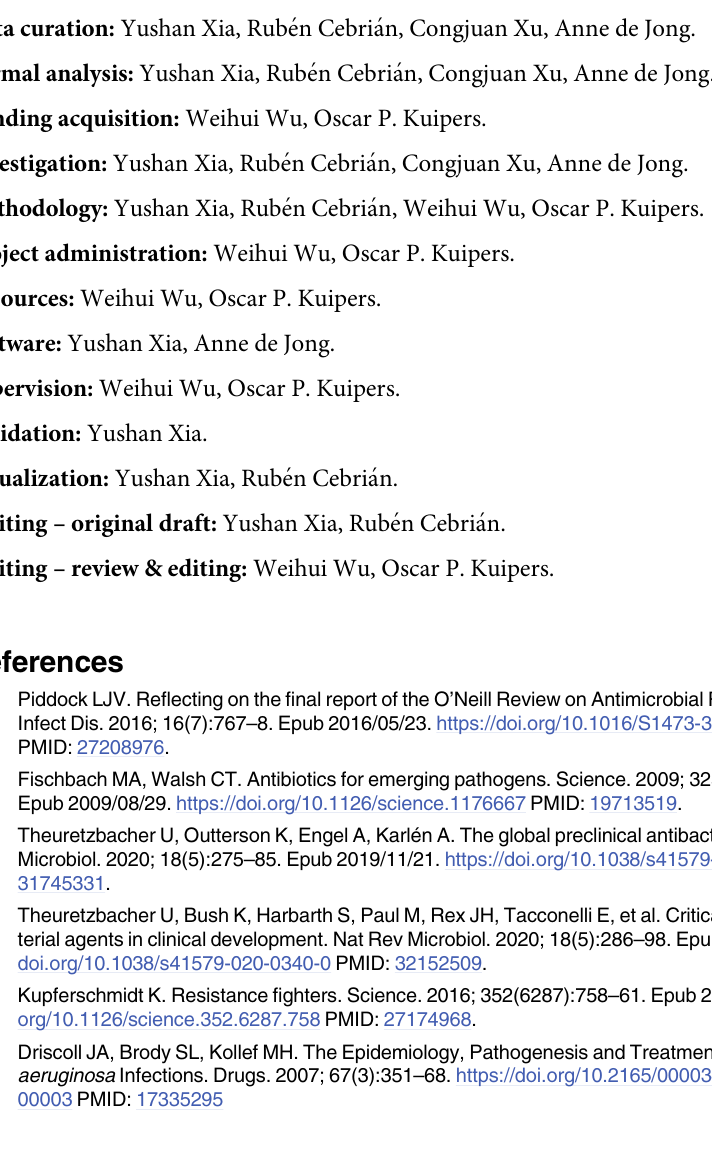
S5 Table. Bacterial strains, plasmids and primers used in this study. S6 Table. The antibiotic sensibility of the clinical P . aeruginosa